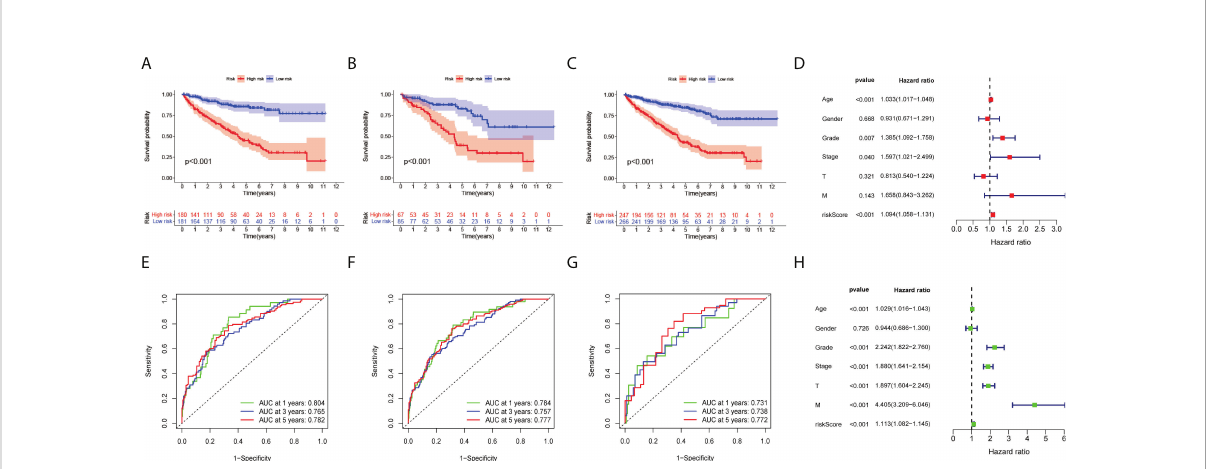
FIGURE 3 Development of eight risk genes for ccRCC. (A-C) Kaplan – Meier OS curve for high- and low-risk groups. (A) Training group, (B) validation group, and (C) TCGA dataset. (D) Forest plots displayed the univariate Cox regression analysis results of the risk score and clinical factors with OS. (E-G) Receiver operating characteristic curves (ROC curves) for the 1-, 3- and 5-year OS periods. (E) Training group, (F) validation group, and (G) TCGA dataset. (H) Forest plots display the multivariate Cox regression analyses results of the risk score and clinical factors with